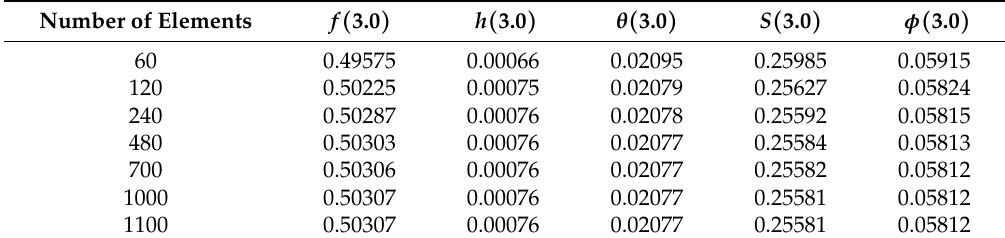
Table 2. FEM convergence results for passive control of nanoparticles when Pr = 0.773; M = 2; B m =